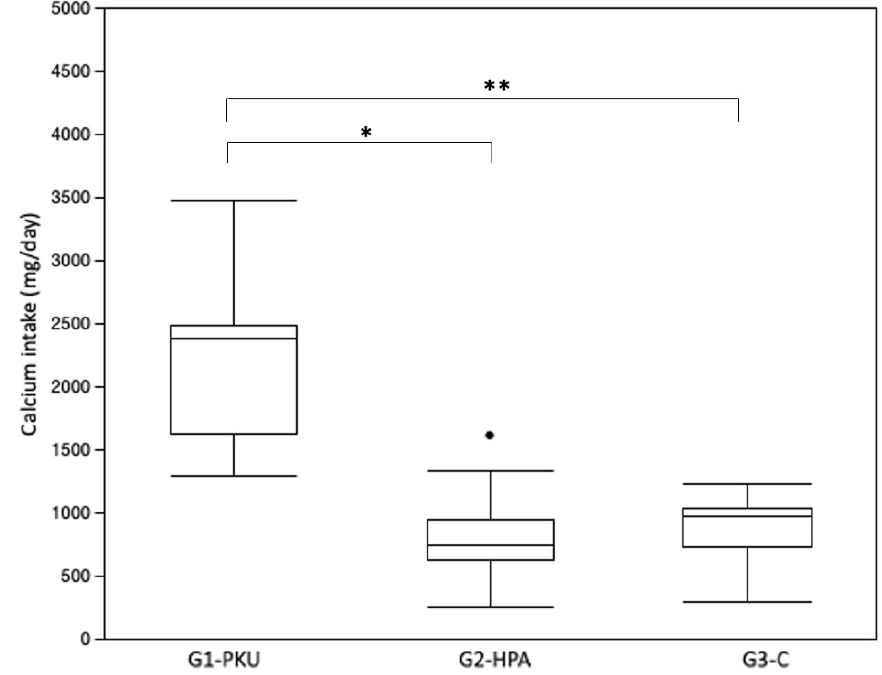
Figure 4. Intake Calcium for groups. Intake vitamin D for three groups of patients: Group 1: PKU, Group 2: HPA and Group 3: Control (n = 48). Groups were compared by Kruskal-Wallis test. The horizontal middle line represents the median and 95% confidence interval (CI). A significant difference is observed between G1-PKU and G2-HPA (*p=<0.05); G1- PKU and G3-C